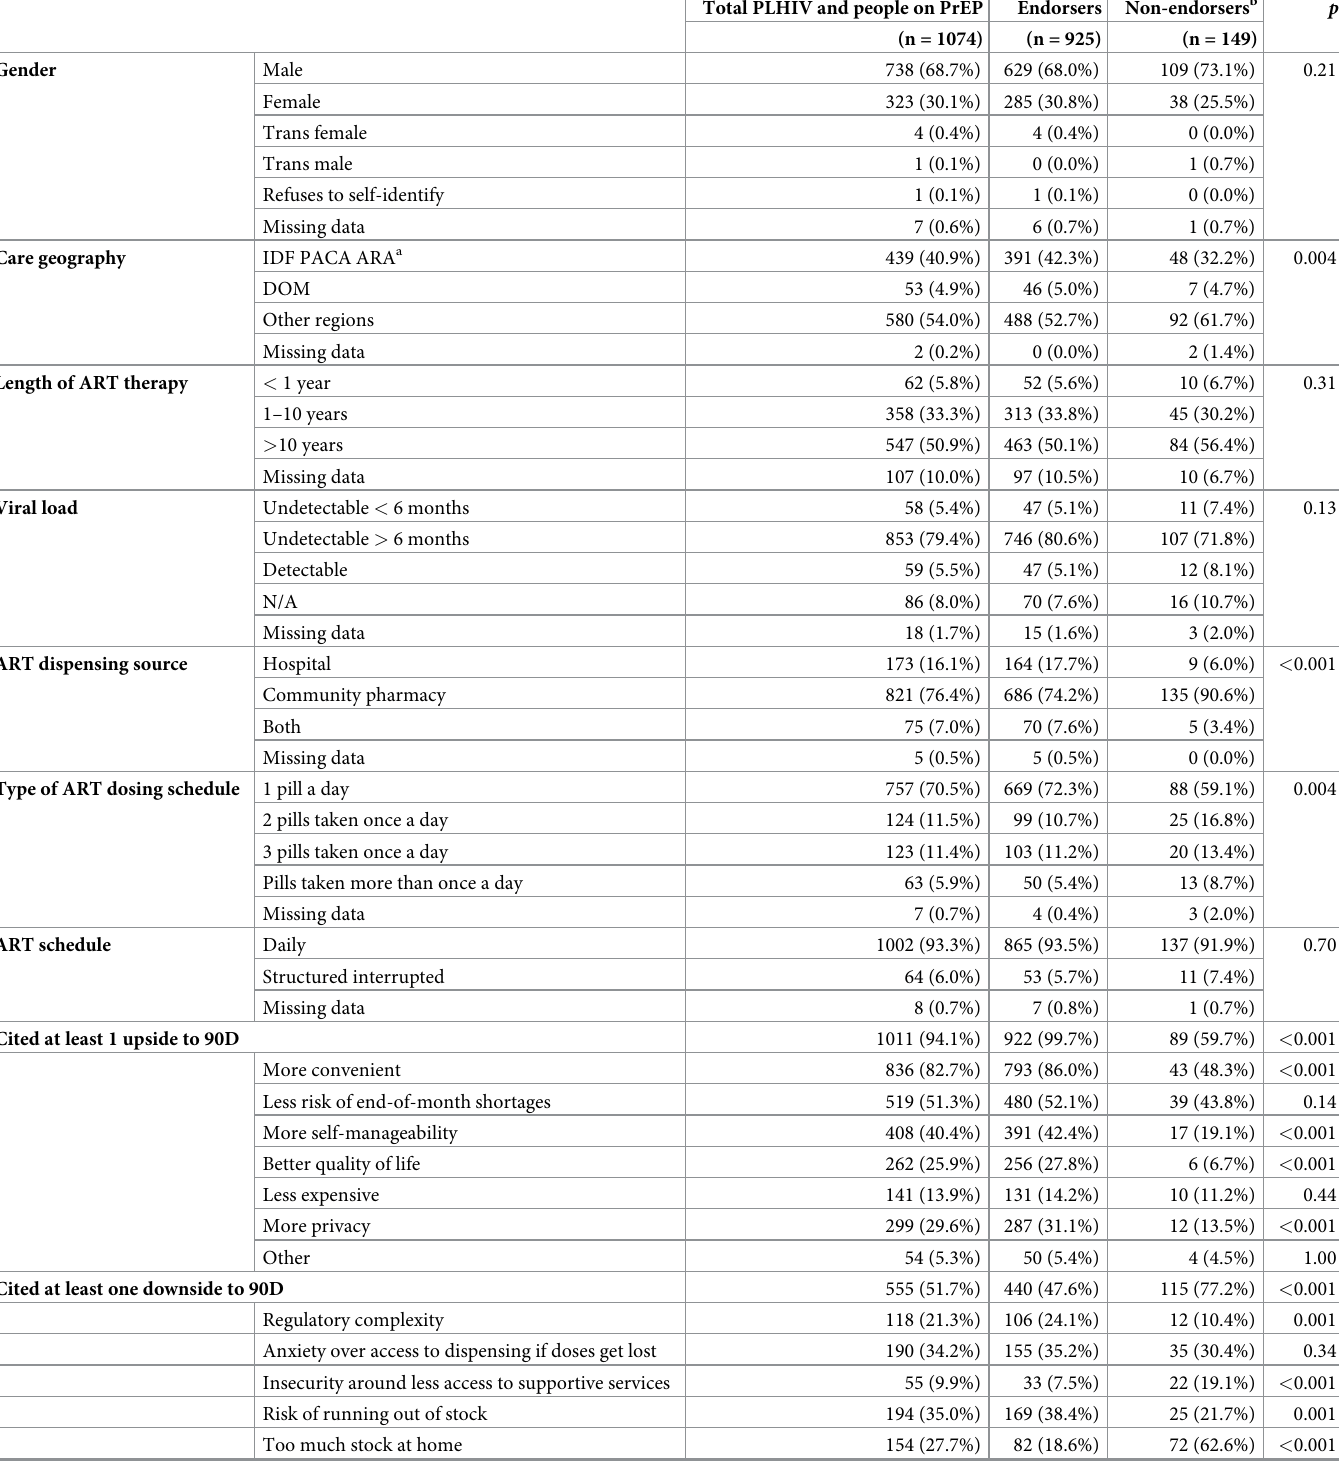
Table 3. Characteristics of in-sample PLHIV and in-sample people on PrEP stratified as endorsers vs non-endorsers of 90-day ART dispensing (n =